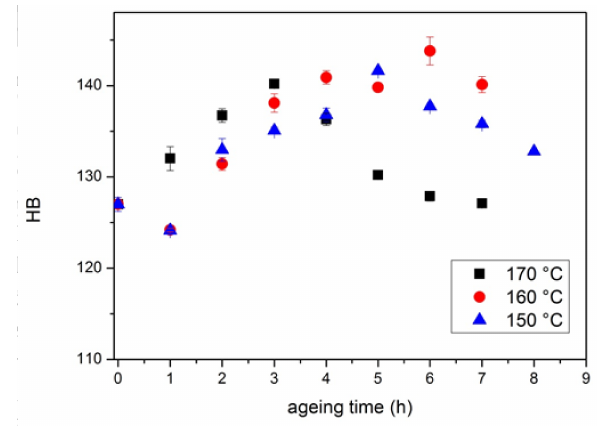
Figure 6. FE-SEM micrographs of 50% 7075 built with the optimized parameters.